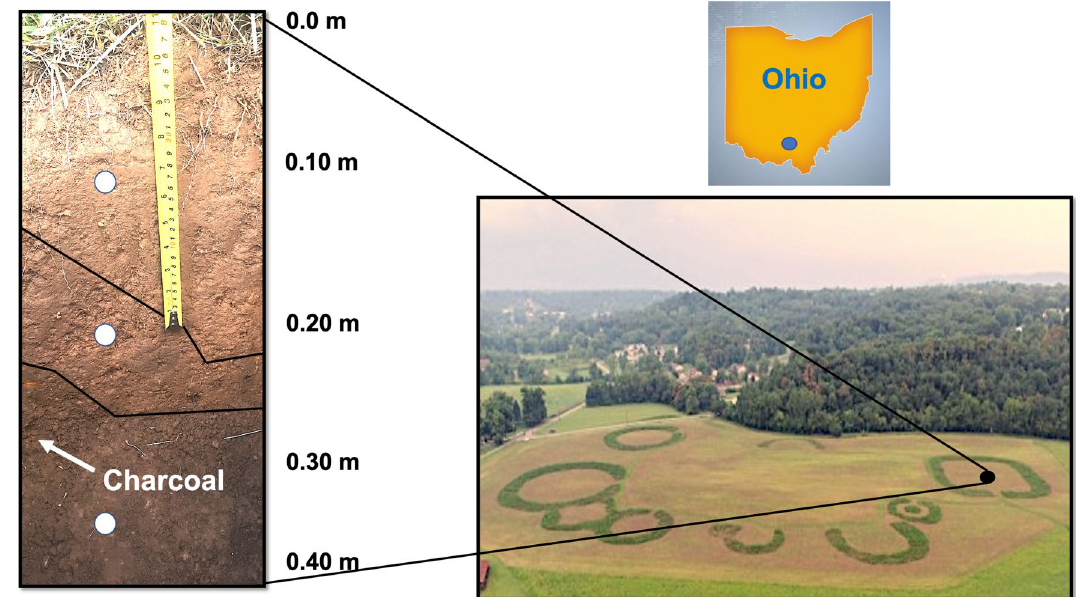
Figure 12. The location, stratigraphy, and sediment sample sites (white circles) of the Junction earthworks and mounds, Ross County, Ohio. Kenneth Barnett Tankersley used Microsoft PowerPoint for Mac Version 16.41 (www. micro soft. com) to create this figure.